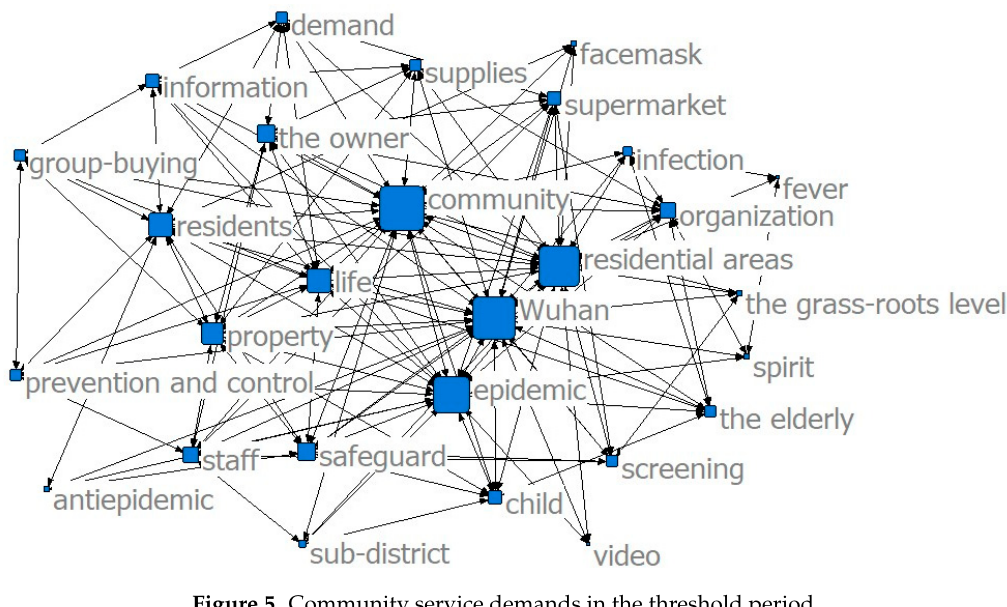
Figure 5. Community service demands in the threshold period.